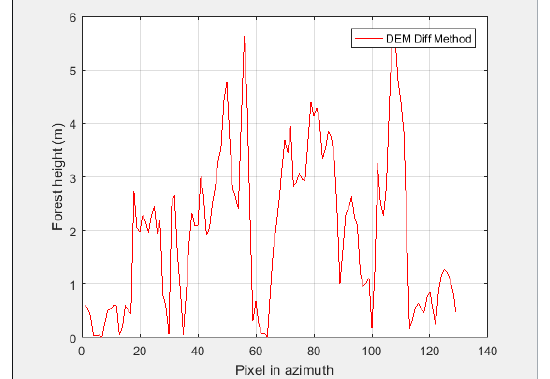
Figure 3. Height estimation result of DEM differencing